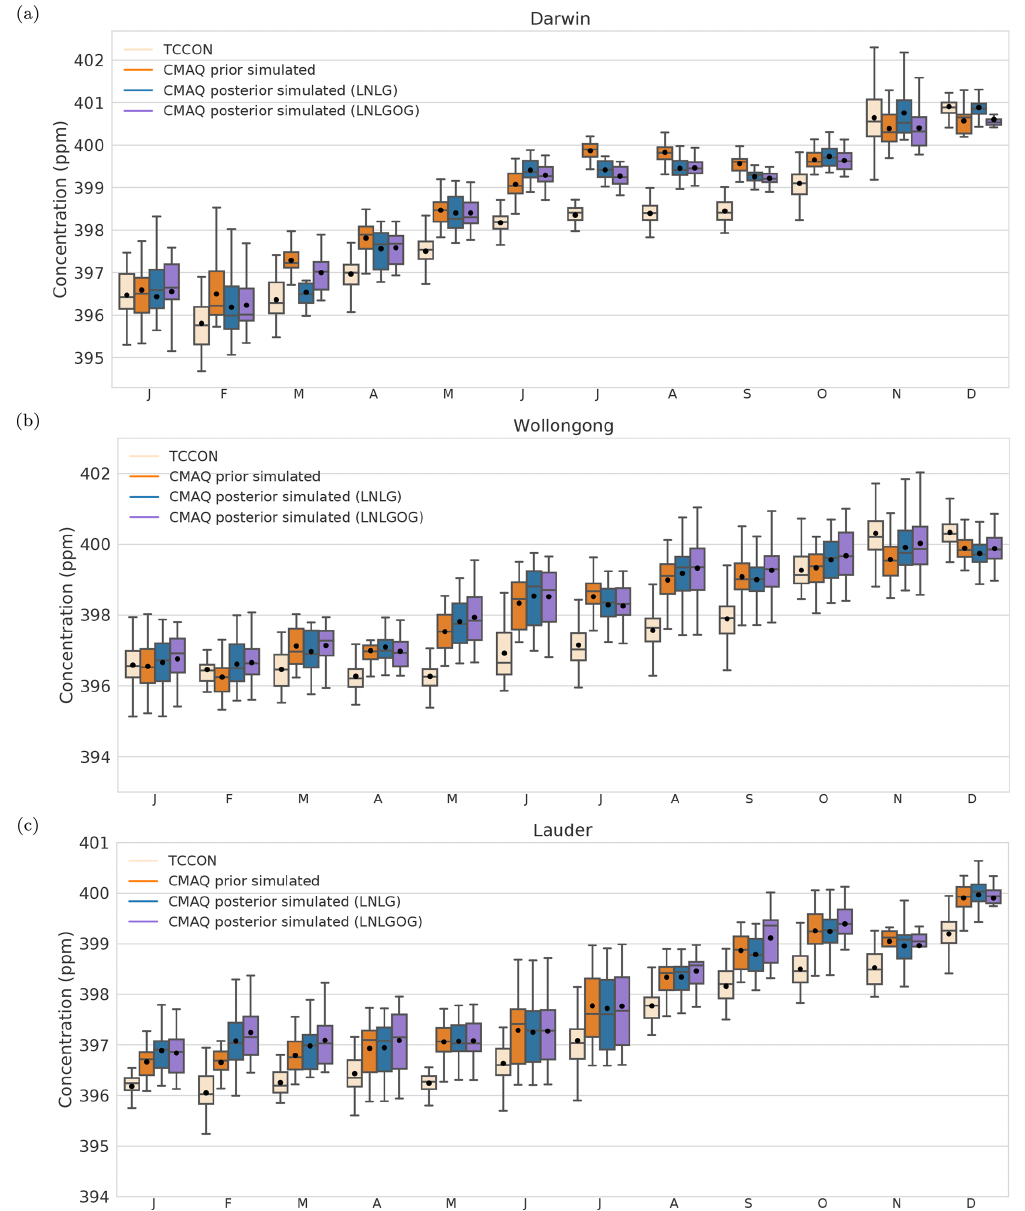
Figure 10. Box plot diagrams show the monthly mean average of CO 2 concentration at the Darwin (a) , Lauder (b) and Wollongong (c) TCCON sites for 2015. The top edge of the box represents the 75th percentile and the bottom edge represents the 25th percentile. The top and bottom whiskers represent the 95th and 5th percentiles. The horizontal black line shows the median and the circle indicates the mean. Mean values are indicated by blue circles and median values by the black